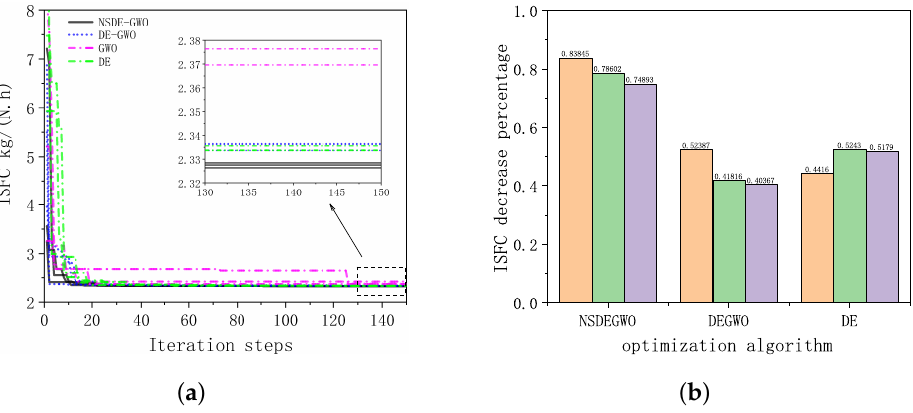
Figure 6. ( a ) Optimization effect of minimum installed fuel-consumption control of four intelligent algorithms (DE, GWO, DE-GWO, NSDE-GWO). ( b ) Histogram of ISFC increase